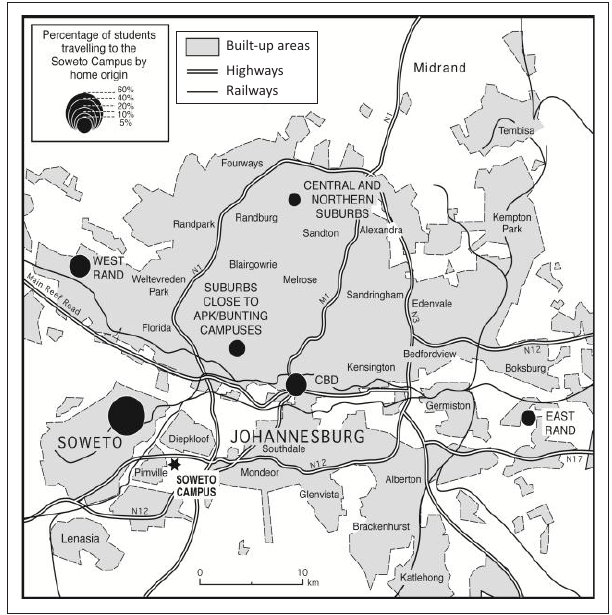
FIGURE 4: Origin of Soweto Campusstudents.